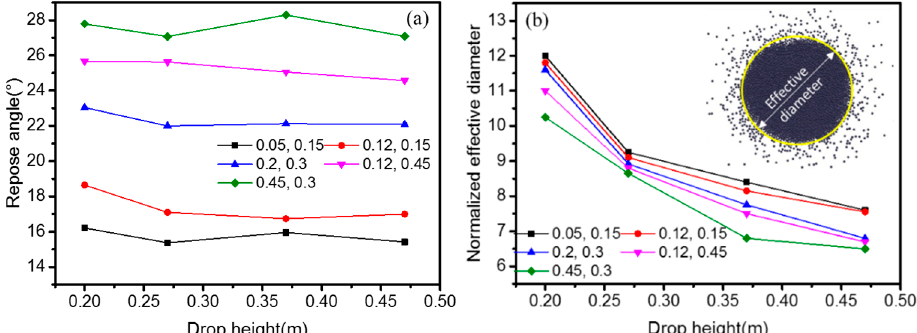
Figure 6. ( a ) Angle of repose and ( b ) and normalized effective diameter of the heap (top view) with different coefficient of static and rolling friction for different drop heights in the Discharging Method. (The numbers in the two figures represent rolling and static friction coefficients, respectively) The inserted subfigure in ( b ) is a top view of the simulated pile.